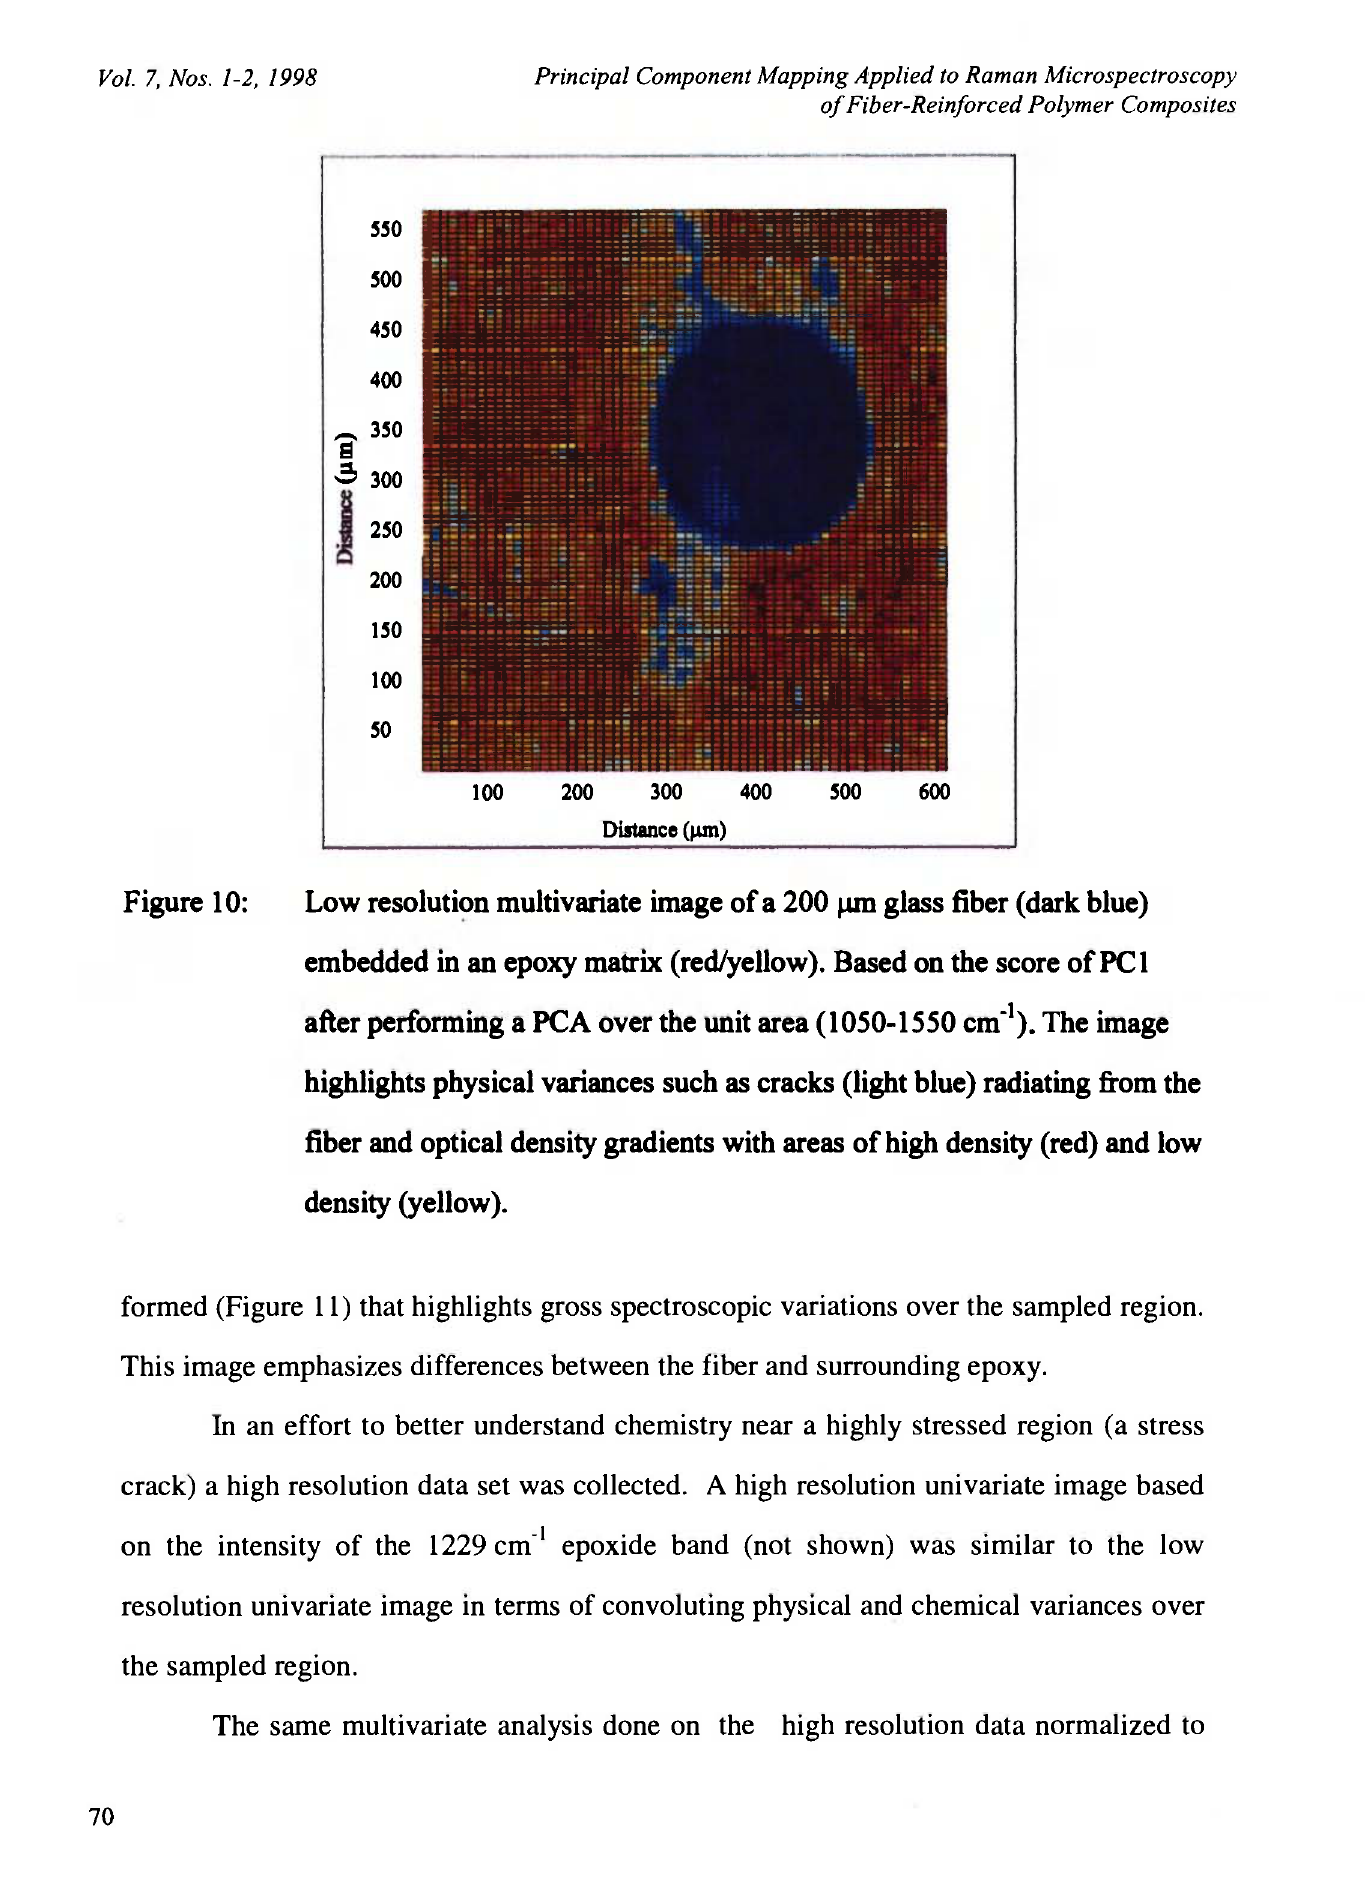
Figure 10: Low resolution multivariate image of a 200 μπι glass fiber (dark blue) embedded in an epoxy matrix (red/yellow). Based on the score of PCI after performing a PCA over the unit area (1050-1550 cm" 1 ). The image highlights physical variances such as cracks (light blue) radiating from the fiber and optical density gradients with areas of high density (red) and low density